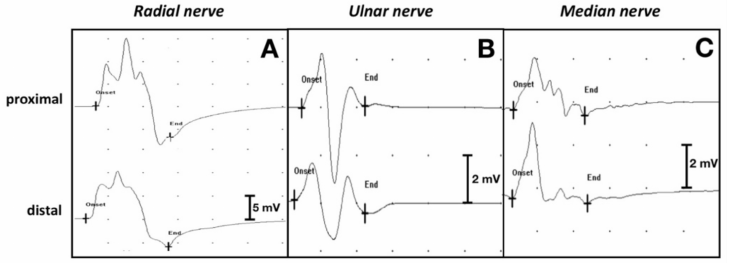
Figure 5. Motor NCS (CMAPs) of the right thoracic limb’s nerves (healthy control) at 5 weeks after admission. Sweep speed: 5 ms/div. CMAP amplitudes, areas, and nerve conduction velocity (NCV) for each tested nerve are reported: ( A ) Radial nerve (proximal CMAP amplitude 23.7 mV, area 73.3 uVs; distal CMAP amplitude 16.3 mV, area 62.4 uVs; NCV 53.6 m/s). Sensitivity: 5 mV/div; ( B ) Ulnar nerve (proximal CMAP amplitude 5.5 mV, area 9.3 uVs; distal CMAP amplitude 3.2 mV, area 7.8 uVs; NCV 44.4 m/s). Sensitivity: 2 mV/div; ( C ) Median nerve (proximal CMAP amplitude 2.8 mV, area 6.6 uVs; distal CMAP amplitude 3.9 mV, area 8 uVs; NCV 125 m/s). Sensitivity: 2